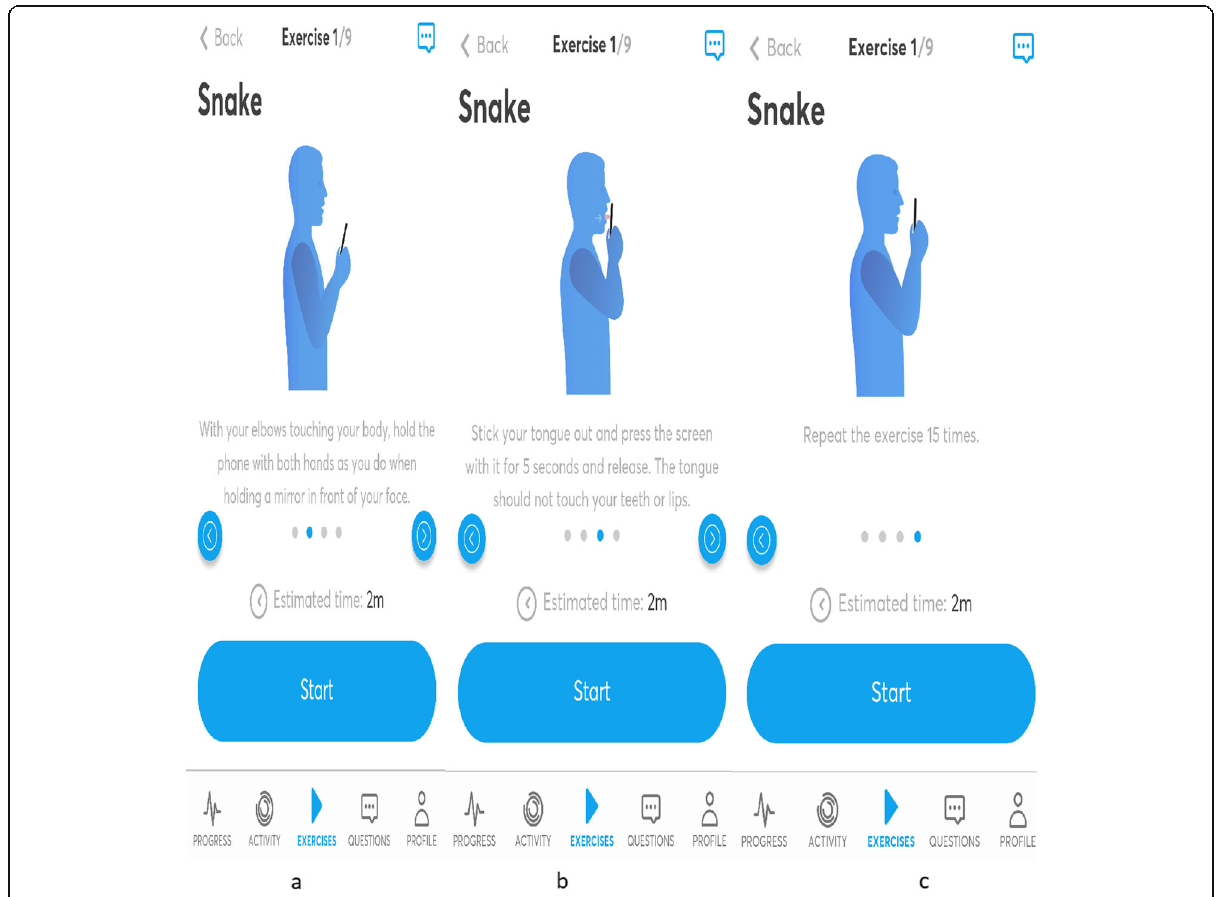
Fig. 1 a – c Exercise snake where patient should touch with his tongue the screen press it with suitable rhythm and strength and receive a positive sound of